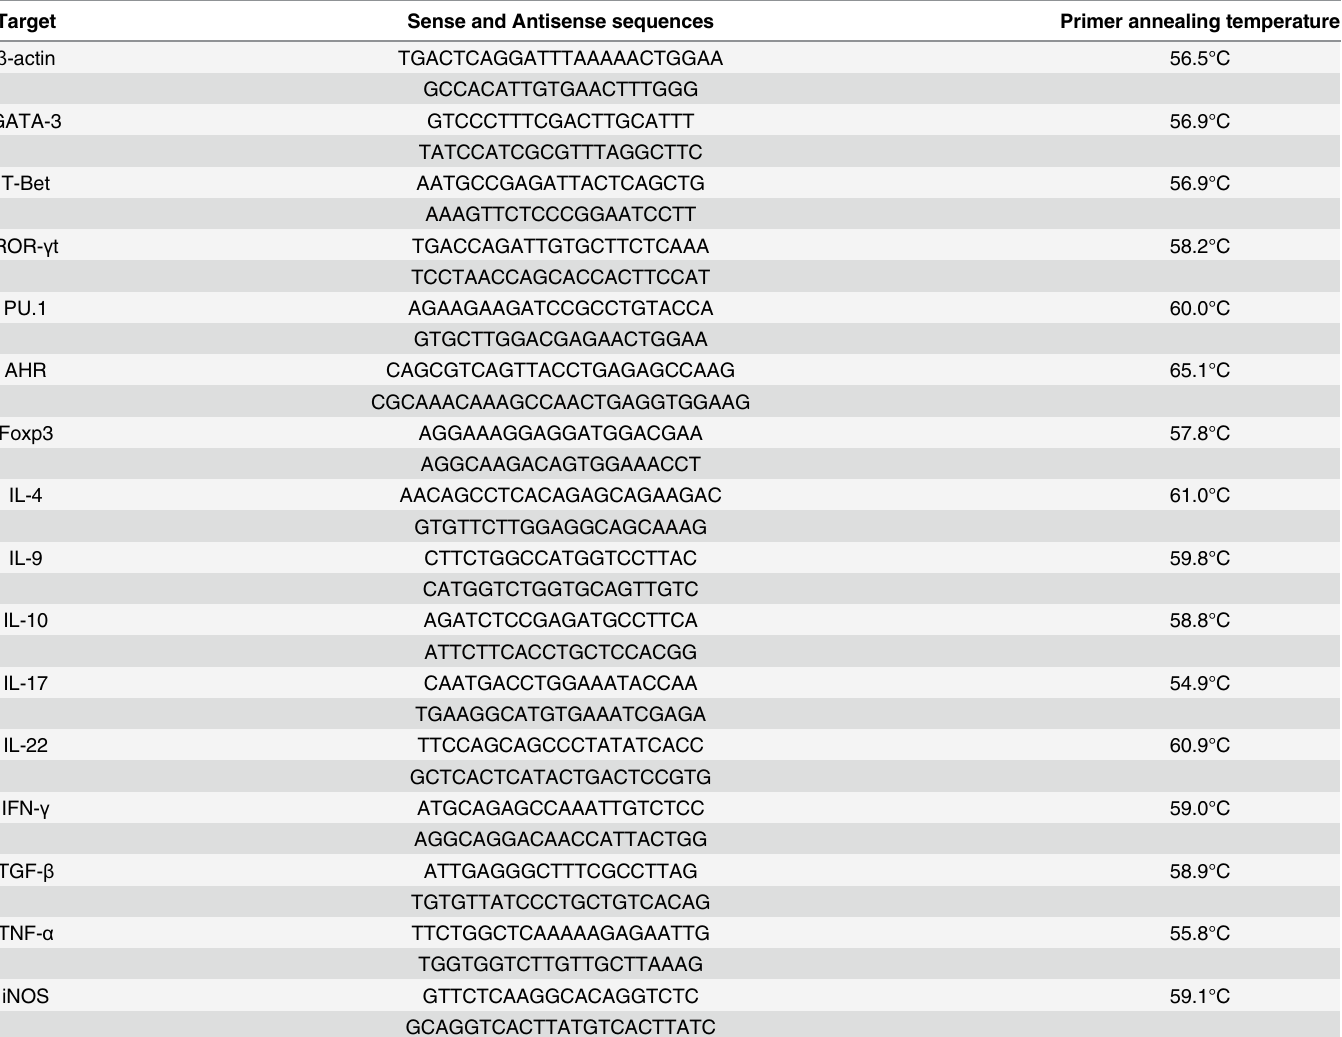
Table 2. The sequences of the primers were designed based on nucleotide sequences in the GenBank Database and were used as follows.